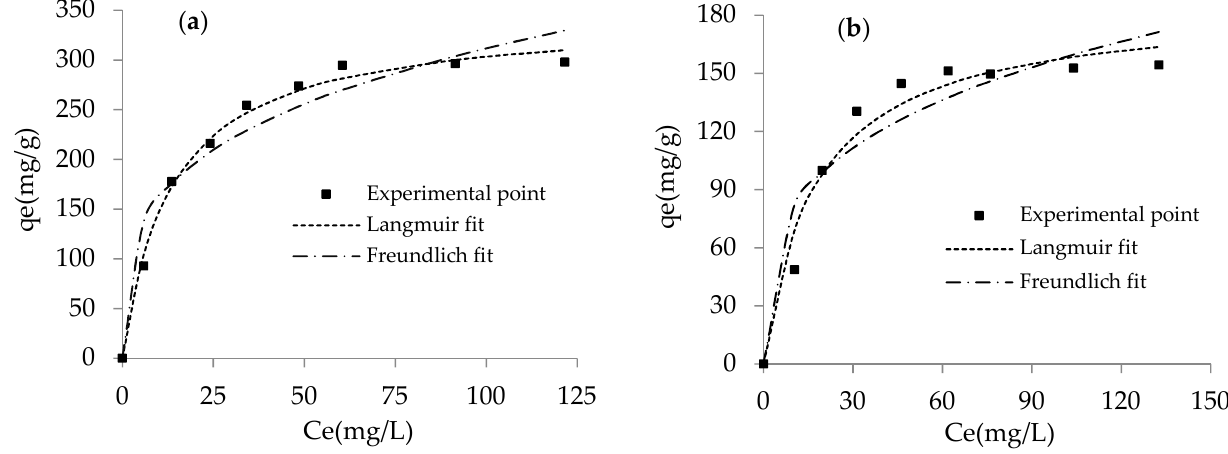
Table 4. Isotherm models constants calculated for PBV adsorption by Fresh and calcined LDH. Adsorbent